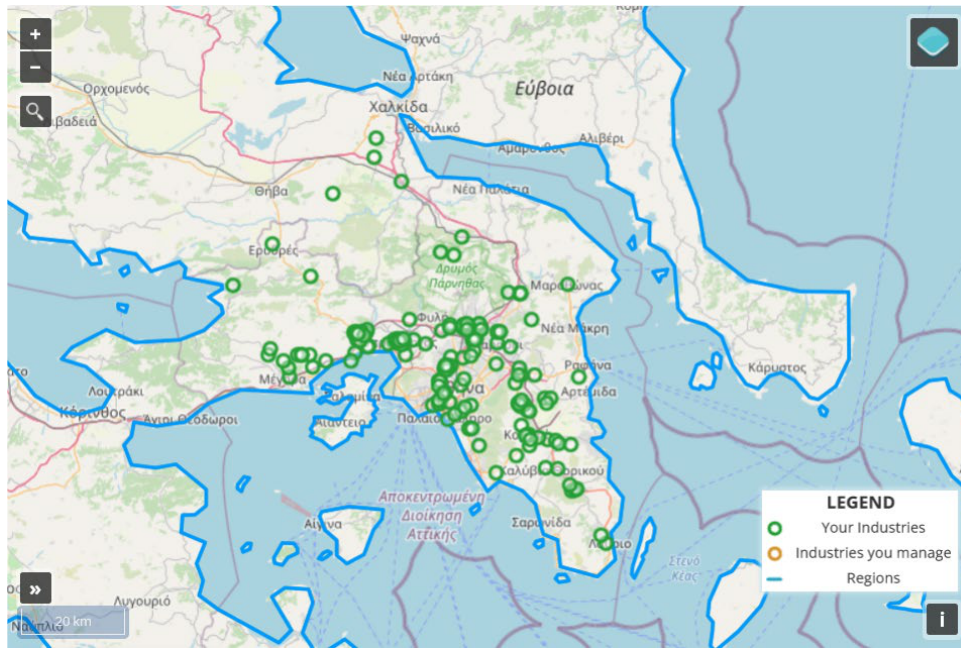
Figure 9. Map of Greek participants (screenshot from www.swanplatform.eu, accessed on 6 May 2022). May